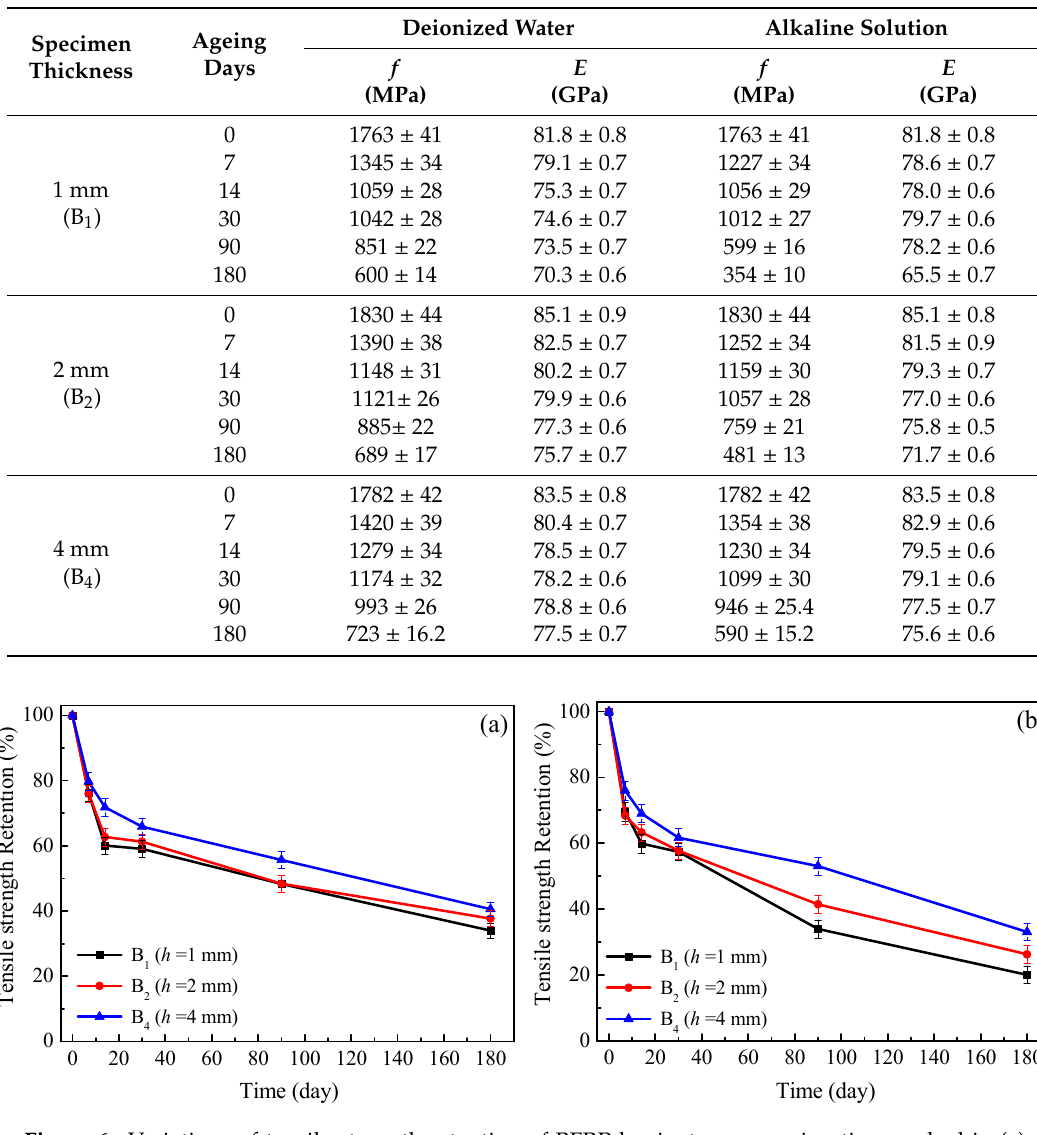
Figure 6. Variations of tensile strength retention of BFRP laminates vs. ageing time soaked in ( a ) deionized water and ( b ) alkaline solution at 60 °C.